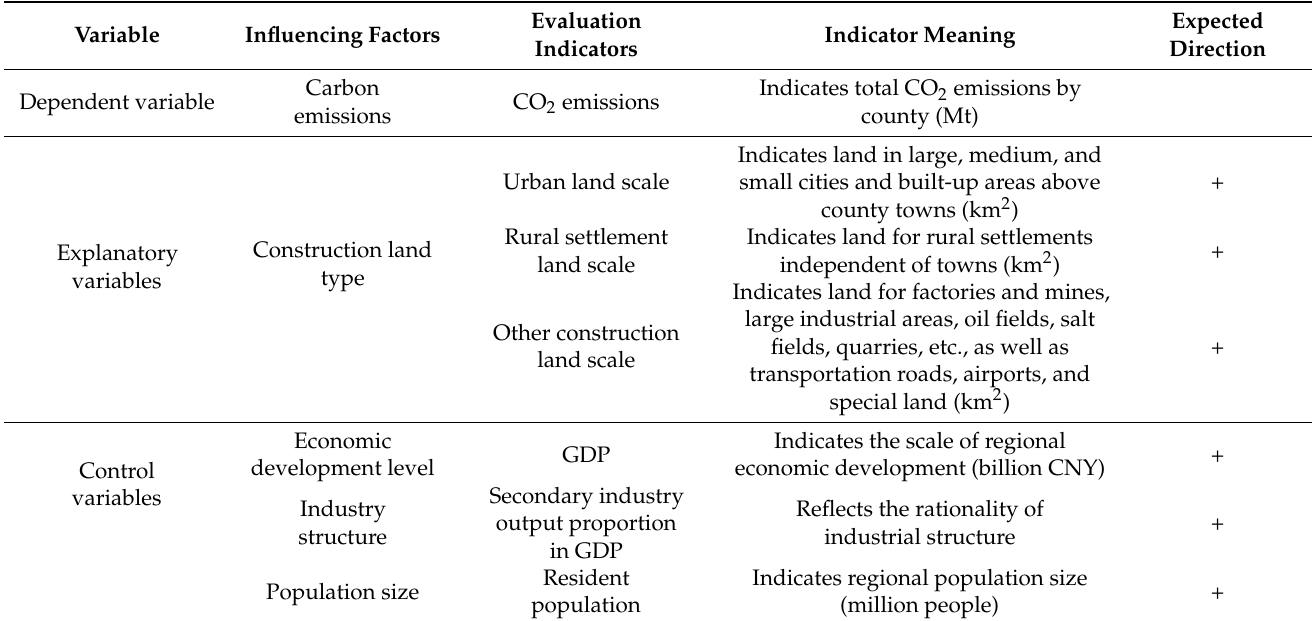
Table 1. Definitions of the